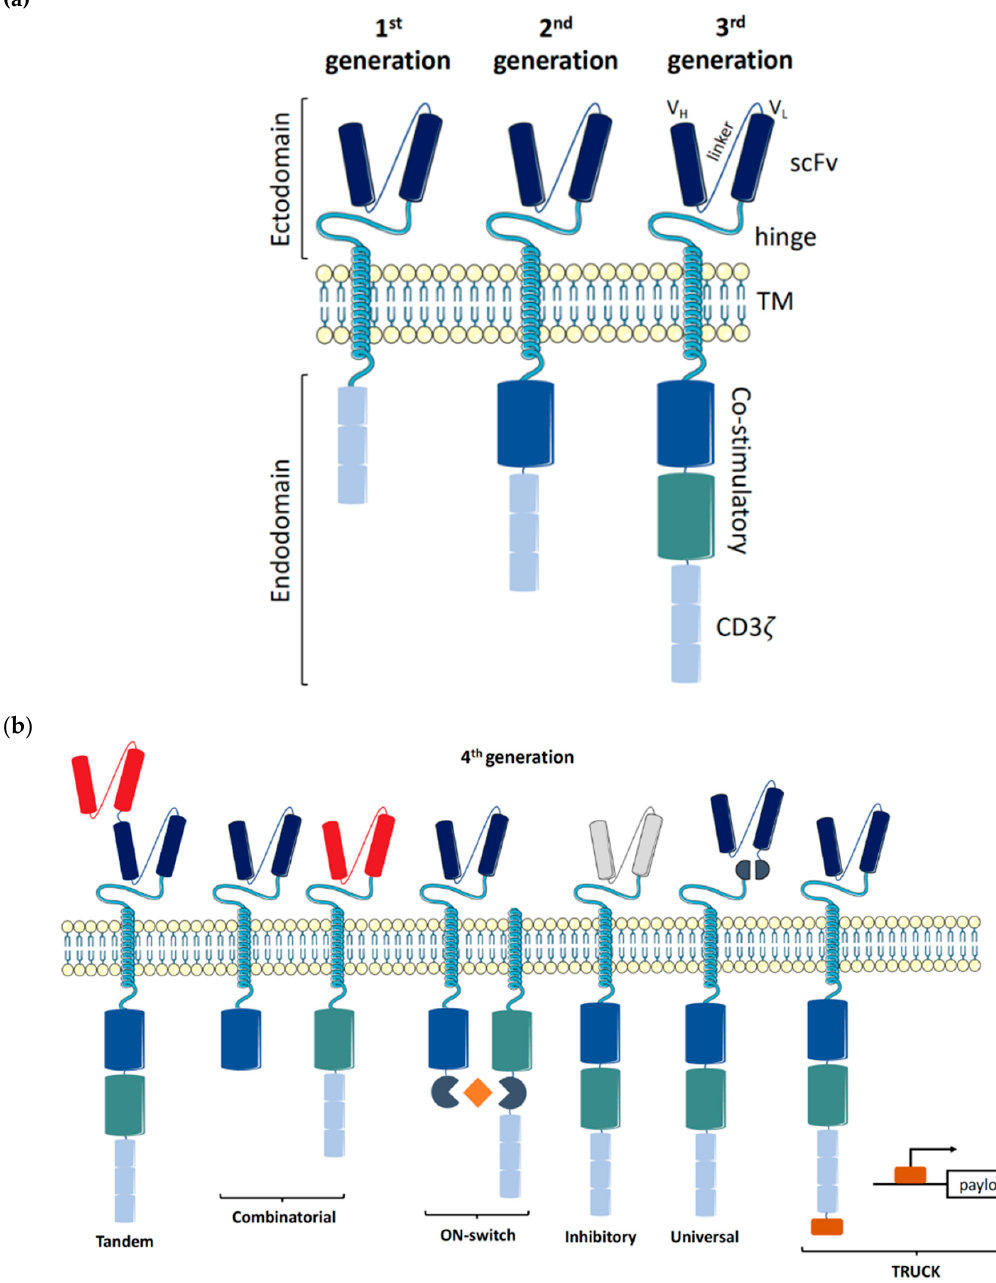
Figure 1. Evolution of chimeric antigen receptor (CAR)-T cell constructs. The main components of a chimeric antigen receptor and its evolution over time. ( a ) 1st, 2nd and 3rd generation CAR constructs; ( b ) Examples of 4th generation CAR construct organized by subgroups. Abbreviations: scFv, single-chain variable fragment; TM, transmembrane; TRUCK, T cells redirected for universal cytokine killing.